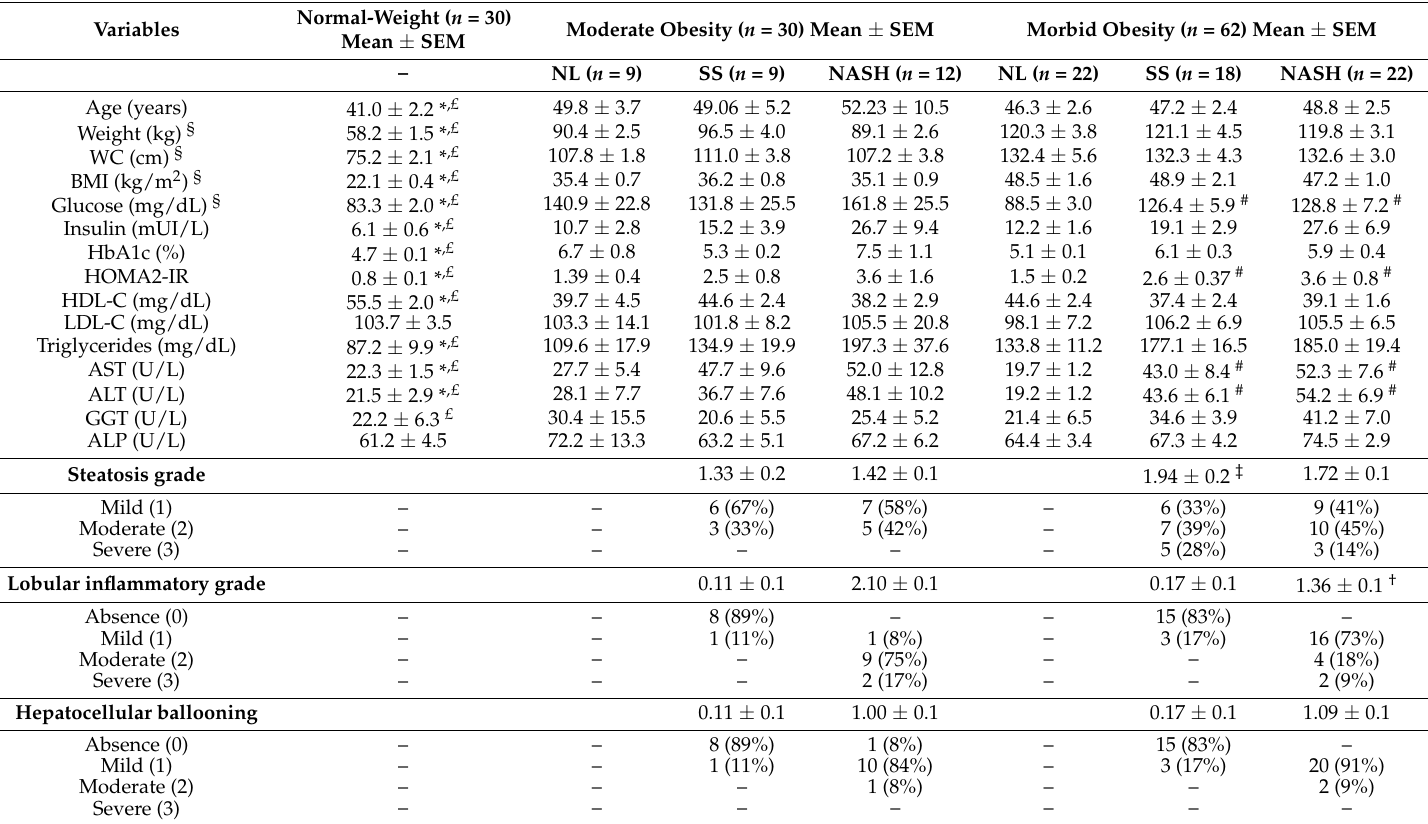
Table 1. Clinical characteristics of the study cohort classified according to the BMI and histopathological characteristics.